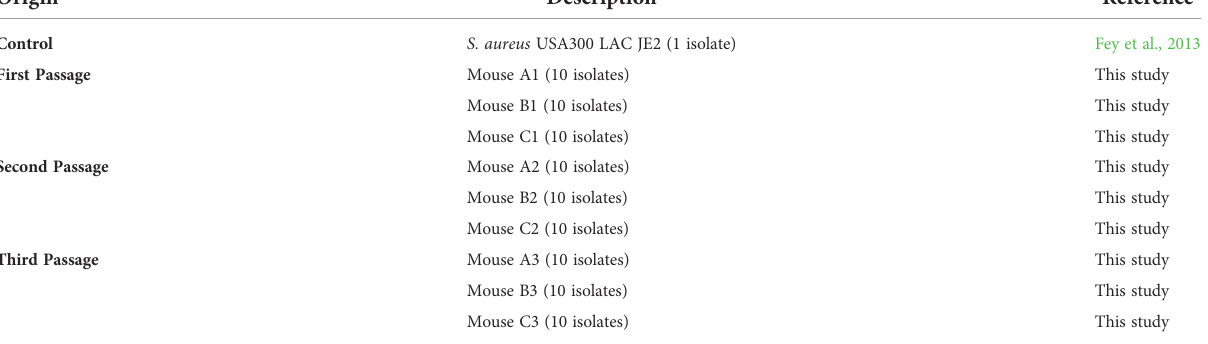
TABLE 1 List of strains used and generated in this